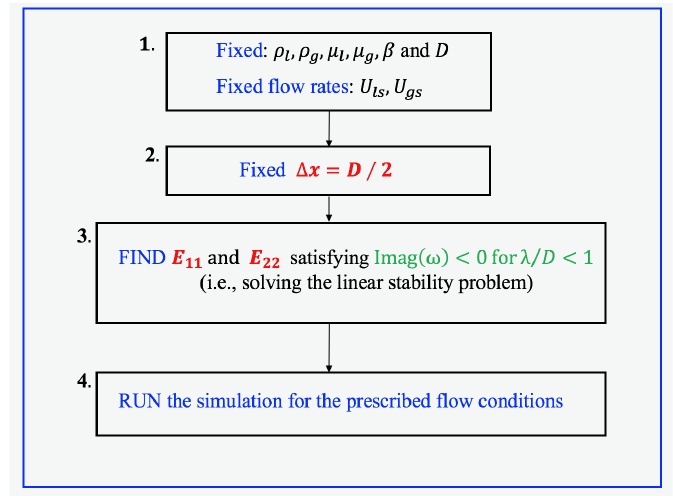
Figure 2. The algorithm implemented to obtain the values of E 11 and E 22